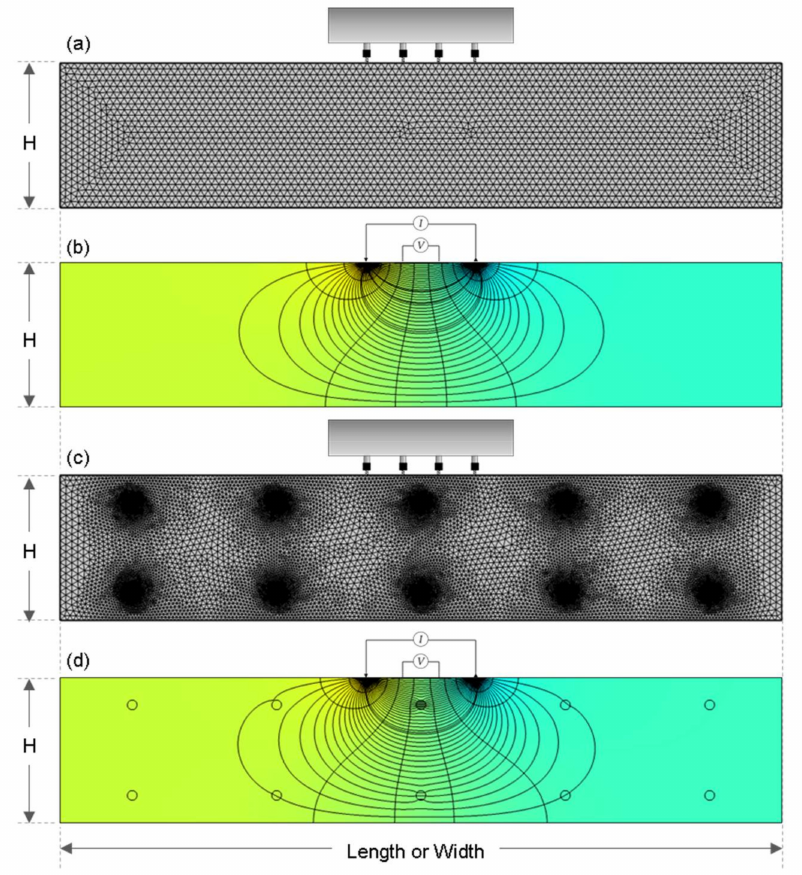
Figure 2. 2D cross-section of finite element models for simulation of electrical field in concrete: ( a , c ) represents a finite element model for a plain and a reinforced concrete slab, respectively; ( b , d ) for the electric potential field in a plain and a reinforced concrete slab,